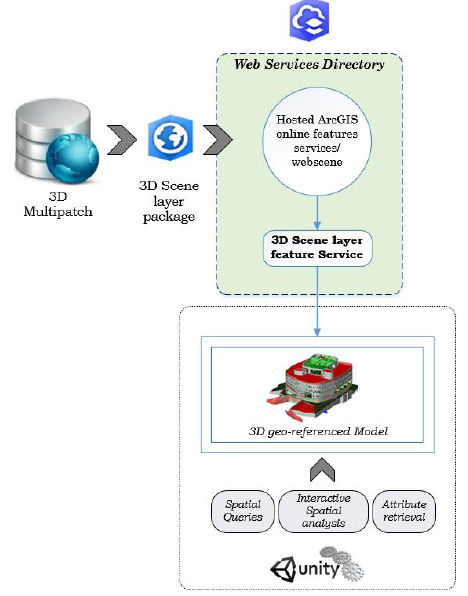
Figure 11. Authoring, publishing and consuming web service on Unity3D game Engine